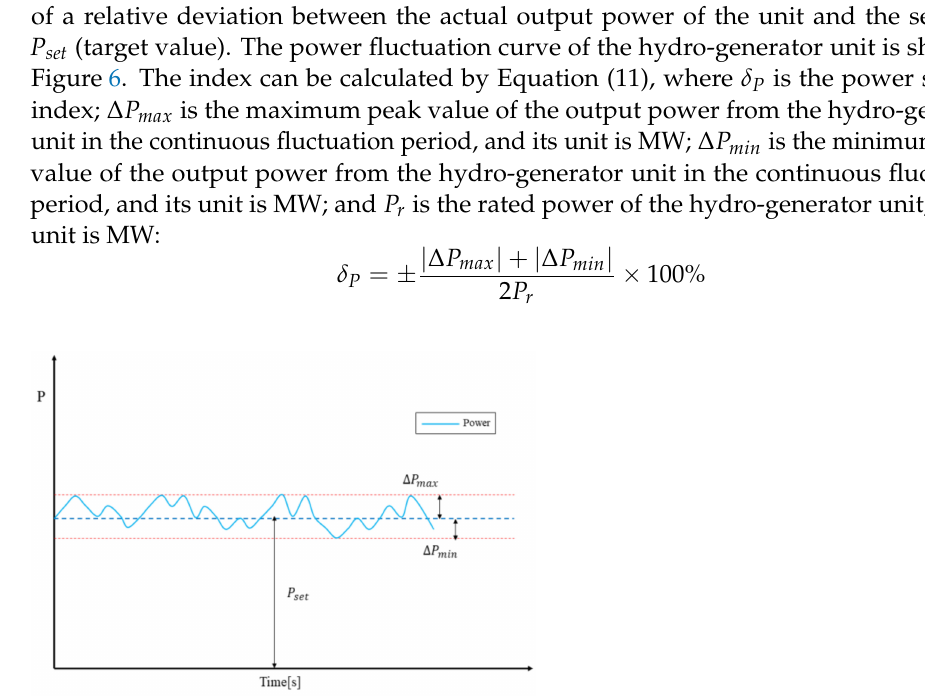
Figure 6. Hydropower unit power fluctuation curve.